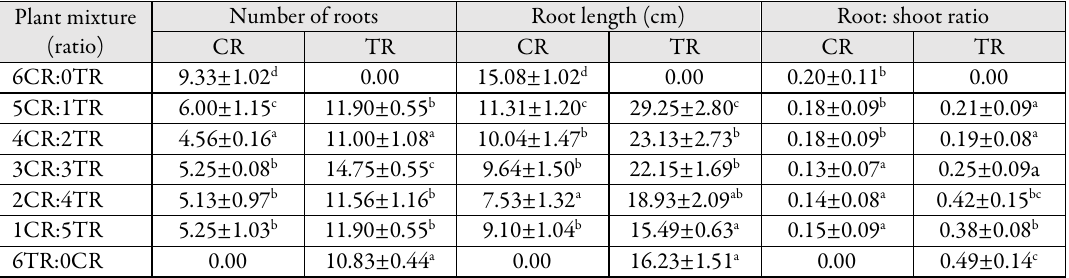
Key: CR= Chromolaena odorata, TR= Tithonia rotundifolia. Values are mean ± standard error for 5 replicates. Means with similar alphabets in superscript on the same column are not significantly different from each other at p≥0.05 (Duncan Multiple Range